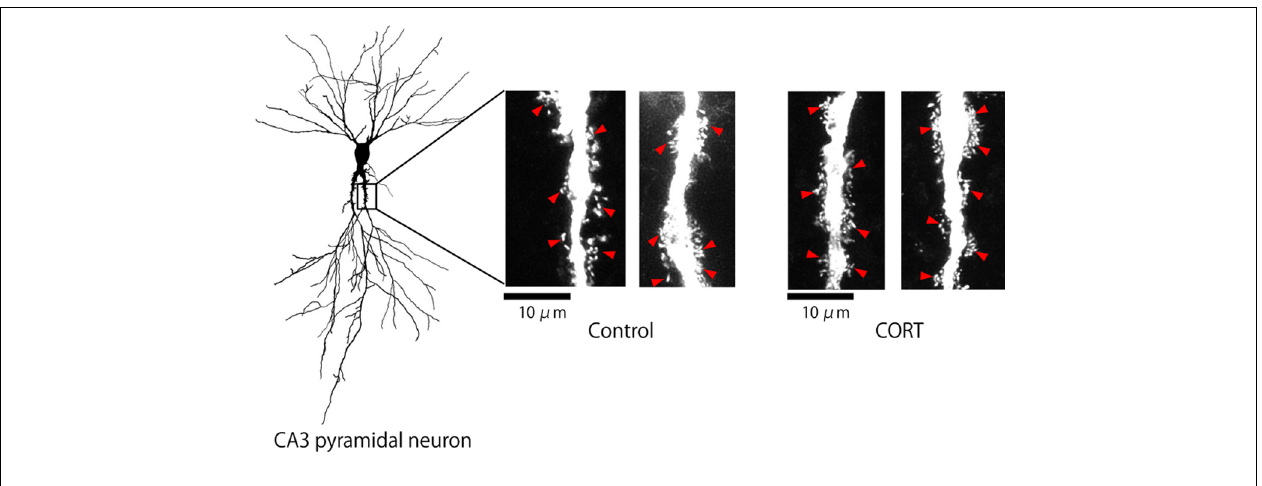
a traced whole image of Lucifer Yellow-injected CA3 neuron. Right images show thorns (red arrowheads) without drug-treatments (Control) or thorns after 1 μ M CORT treatments (CORT) for 1 h. Bar 10 μ